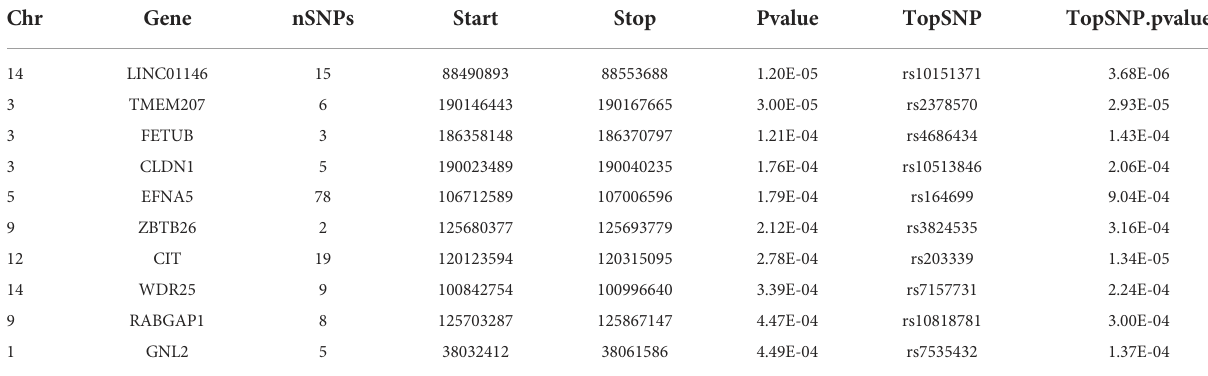
TABLE 3 The top 10 genes from the gene-based